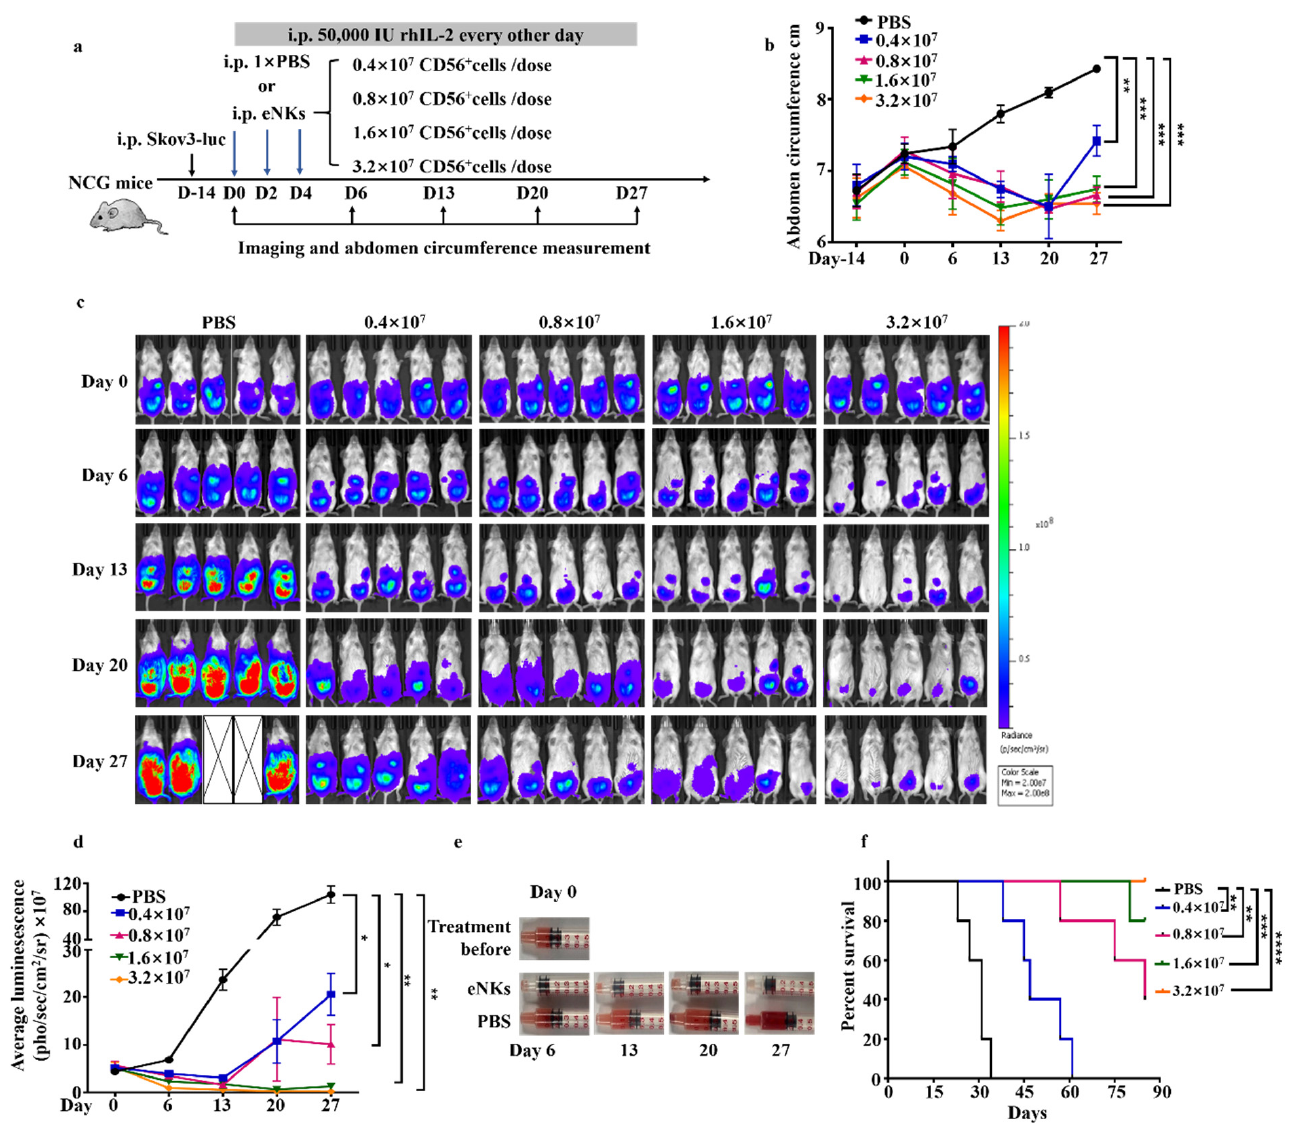
Figure 6. eNKs reduced the ascites burden and improved survival rates in a Skov3 xenograft model of human OC. ( a ) Experimental design for intraperitoneal adoptive transfer of eNKs into xenograft mice beginning 2 weeks following injection of Skove3-luc. ( b ) Abdominal circumference was quantified for each group at the indicated times ( n = 5 mice per group from one experiment). ( c ) Bioluminescence imaging was used to quantify tumor burden after eNK transfer over 27 days. ( d ) Summary of bioluminescence measurements for each group at the indicated times ( n = 5 mice per group in one experiment). Significant differences were determined using one-way ANOVA. ( e ) Images showing differences in ascites volume between eNK- and PBS-treated groups at the indicated times. ( f ) Mice were monitored for Kaplan–Meier survival curve, and significance was determined by log-rank test. Data are represented as means ± SD. * p < 0.05; ** p < 0.01; *** p < 0.001, **** p < 0.0001.